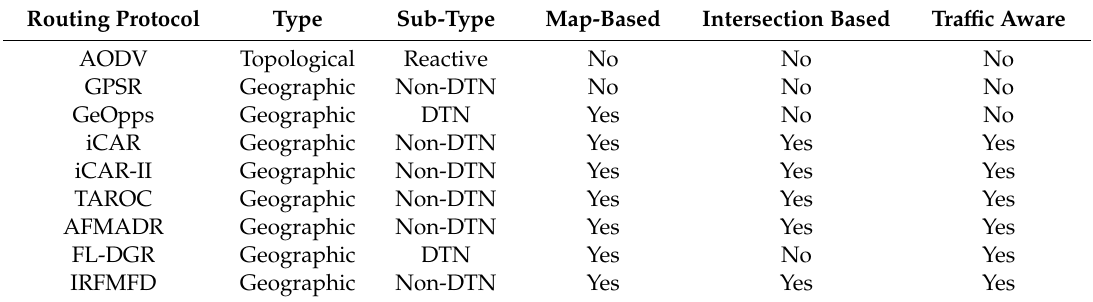
Table 1. Summary of related routing